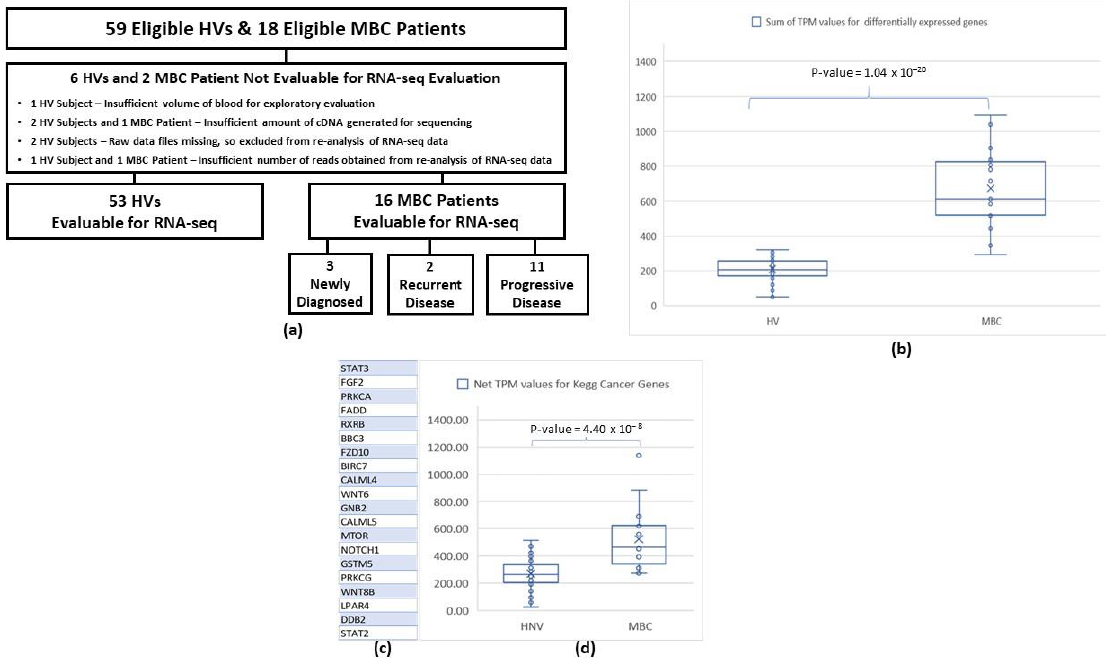
Figure 5. ( a ) Flow diagram for RNA-seq evaluation in eligible HV and MBC patients. ( b ) Sum of TPM values for all genes differentially expressed ( p < 0.001) between Parsortix PC1 harvests obtained from HV comparators and MBC patients. ( c ) Genes from the KEGG Cancer Pathway were differentially expressed between the HV and MBC harvests ( p < 0.05) ( d ). Net TPM score of these 20 genes for HV and MBC samples. CTC, circulating tumor cell; HV, healthy volunteer; MBC, meta- static breast cancer.